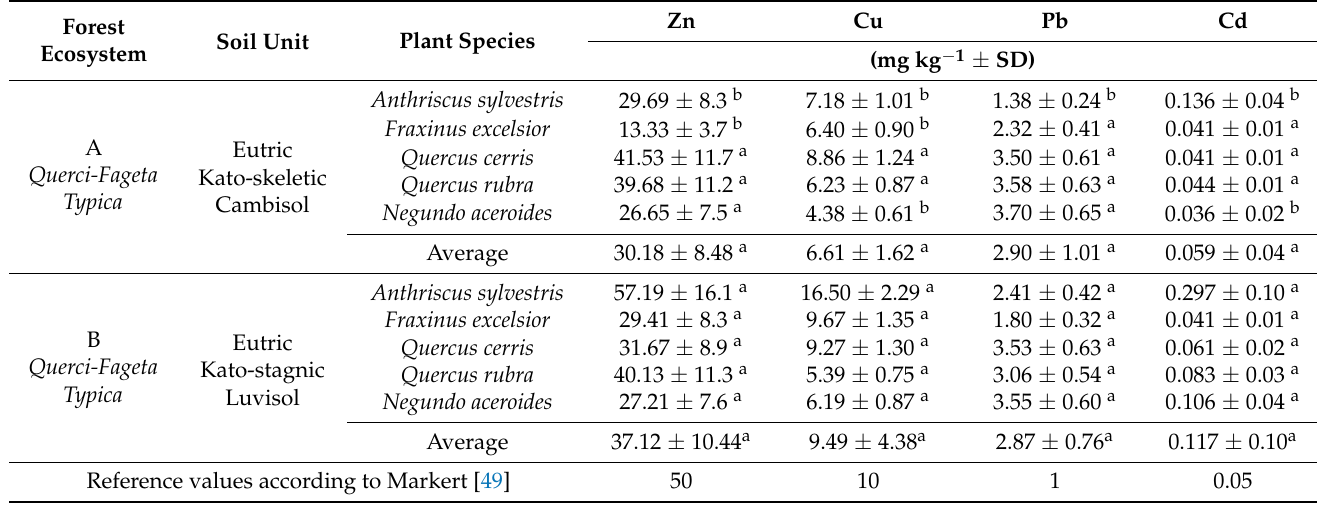
Table 4. The significance of the differences between the concentrations of the elements found in the leaves of the same plant species on Cambisol and Luvisol was tested by ANOVA and Fisher’s LSD test. Significantly different mean values ( p < 0.05) are indicated by different letters ( a,b ).